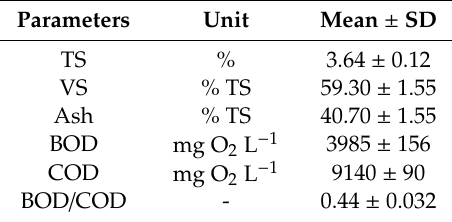
Table 2. Physicochemical parameters of the tested anaerobic